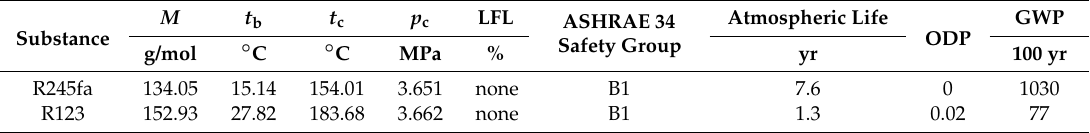
Table 2. Basic thermal properties and environmental properties of considered fluids